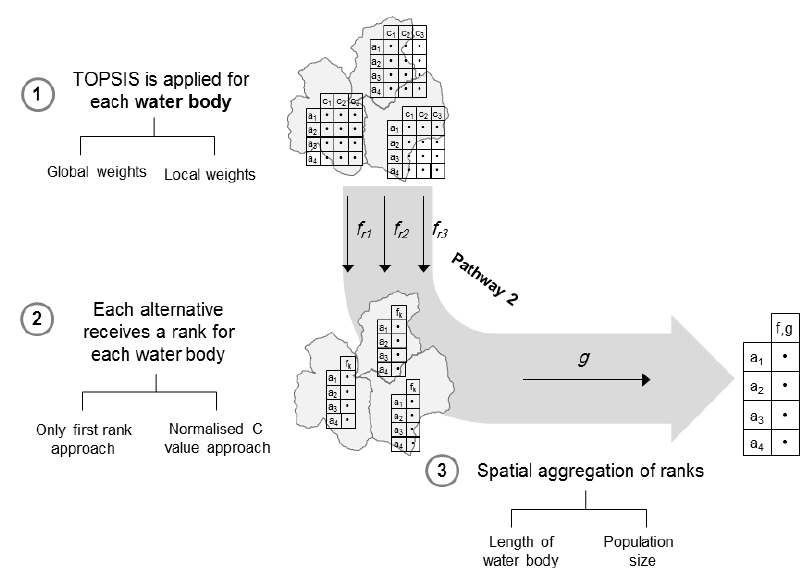
Figure 5. Methodology for pathway (2) considering the water body spatial scale, where we apply the technique for order of preference by similarity to ideal solution (TOPSIS) to each water body and subsequently aggregate the resulting ranks.